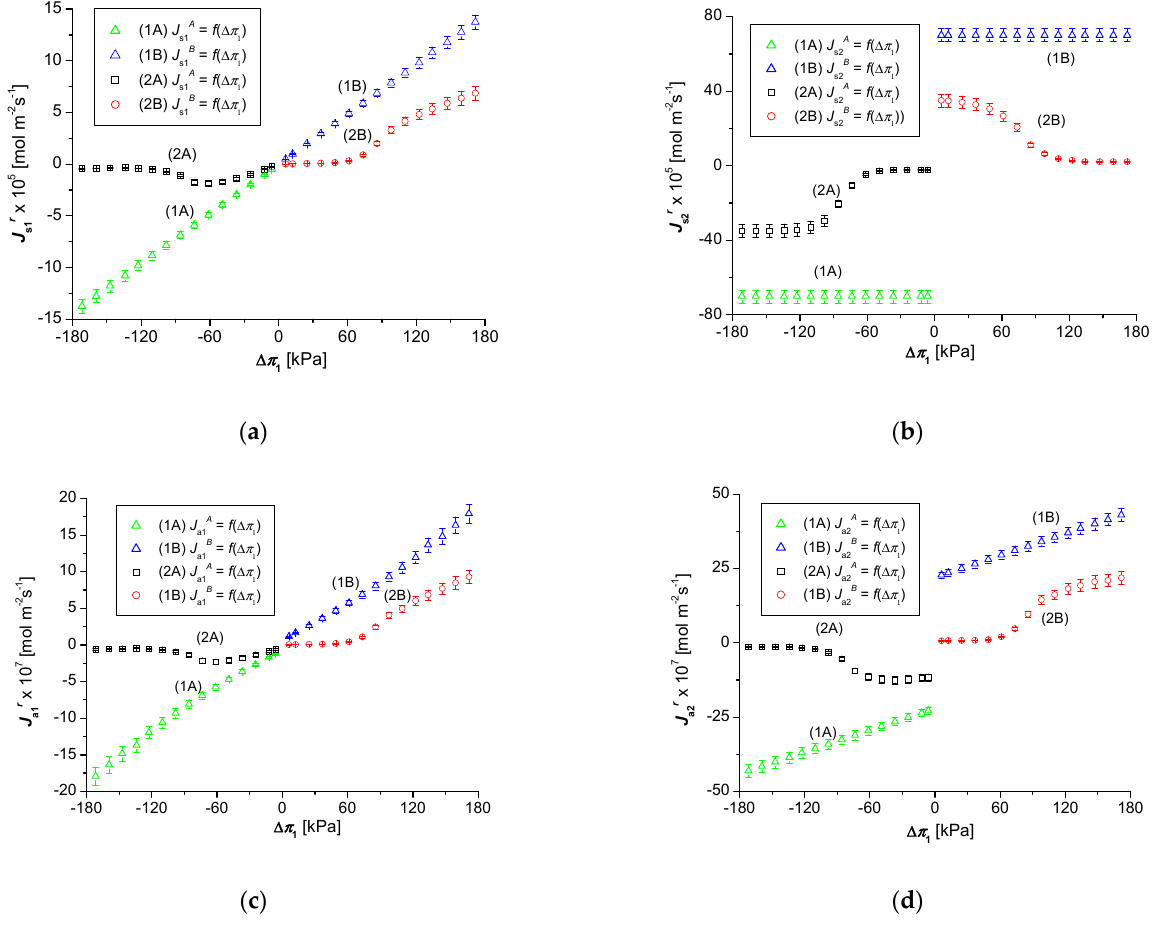
Figure 3. Glucose flux ( J r ) ( a ), ethanol flux ( J r ) ( b ), advective glucose flux ( J r ) ( c ), advective ethanol s 2 s 1 a 1 flux ( J r ) ( d ) as functions of osmotic pressure difference of glucose ( ∆ π 1 ) with a constant osmotic a 2 pressure of ethanol ( ∆ π 2 = 490.3 kPa) and ∆ P = 0: for stirred solutions (1A, 1B), for non-stirred solutions (2A, 2B). Configuration A of the membrane system —curves 1A and 2A, configuration B—curves 1B and